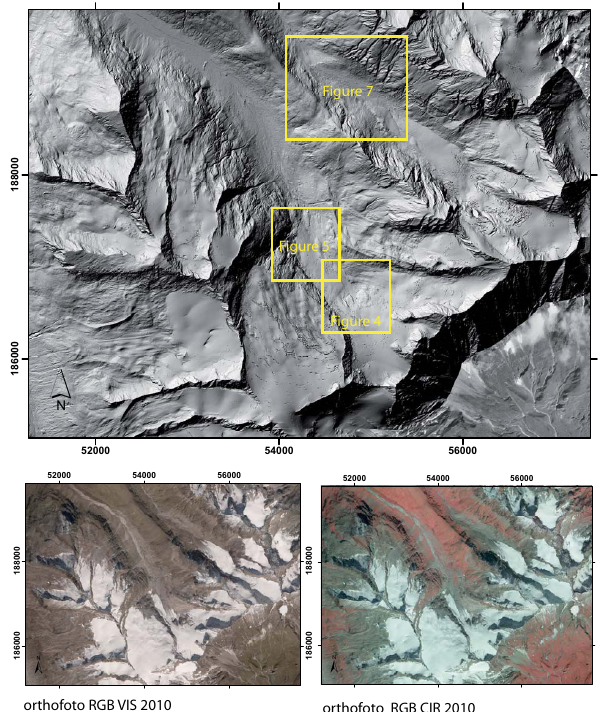
Figure 3. Example of an lidar hillshade (2006) of the same area as in Fig. 2 with VIS and CIR RGB orthophotos from 2010 for comparison. The inserts show the position of the subsets shown in Fig. 4 (lower right rectangle) and Fig. 5 (upper left rectangle).